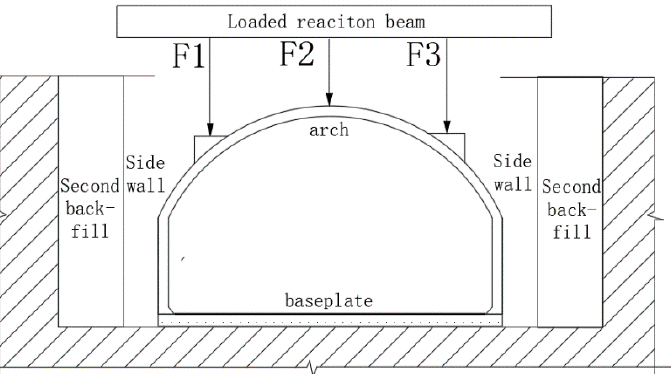
Figure 4. Stress diagram of test model. F1 is the loading point at the arch quarter span; F2 is the loading point at the midpoint of the arch; F3 is the loading point at the three-quarter arch span.